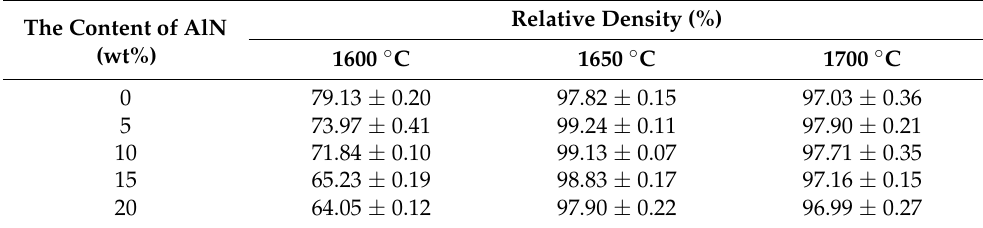
Table 2. The relative density of sintered samples at different